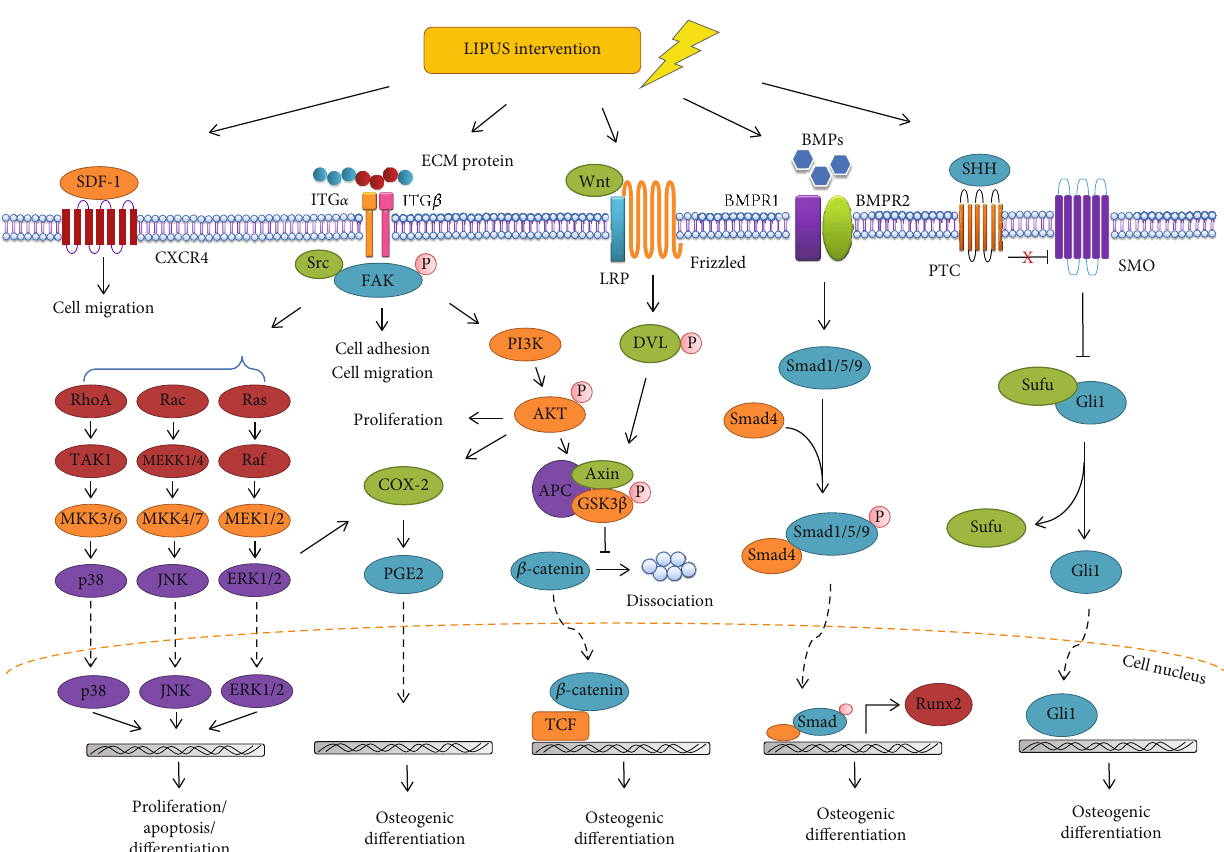
Figure 3: Schematic diagram of signaling pathways that can be activated by LIPUS in bone-derived cells for regulating cell biology functions and implant osseointegration, which include integrin and focal adhesion pathway, MAPK pathway, SHH pathway, BMP/Smad pathway, SDF-1/CXCR4 signaling, and COX-2/PGE2